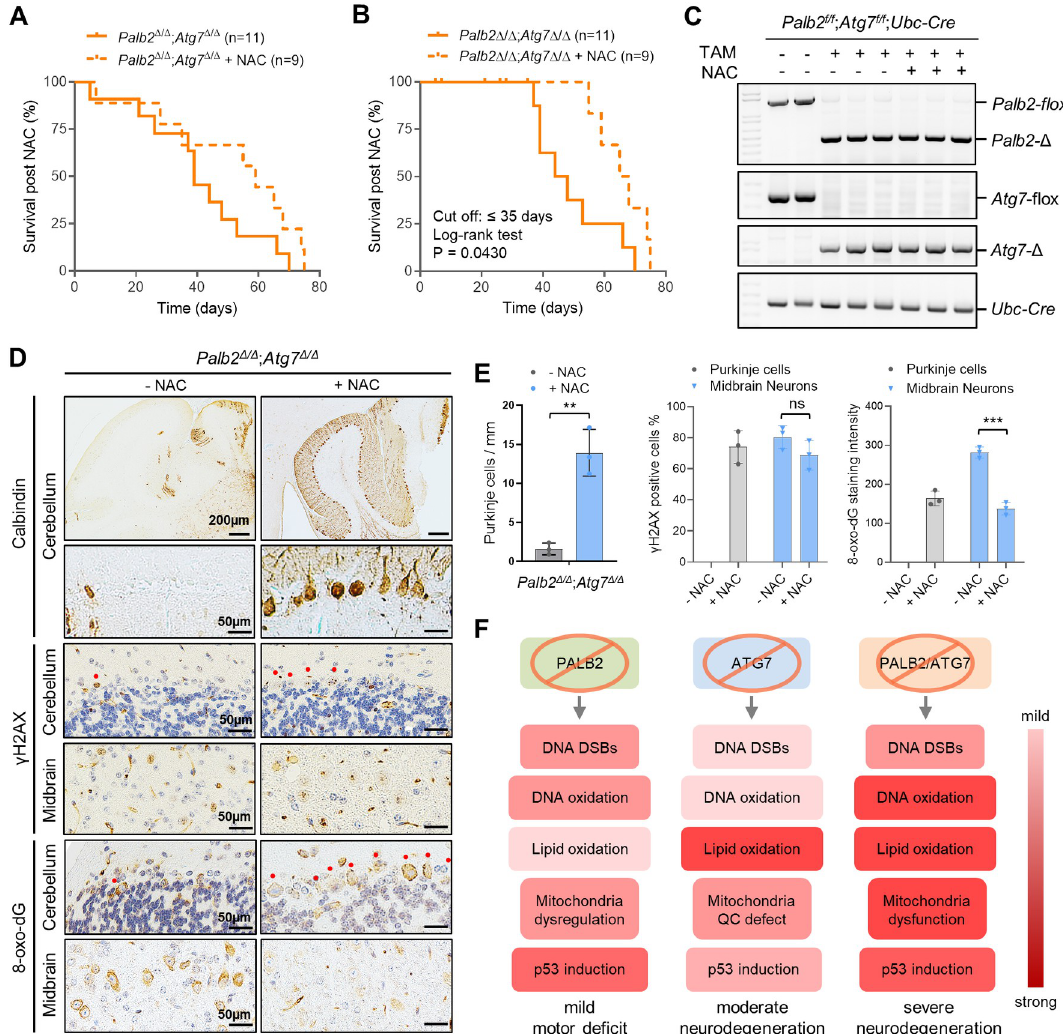
Fig 8. Partial rescue of Palb2;Atg7 -WBKO mouse survival by an ROS scavenger and a summary of key events occurring in the brain of the model mice in this study. (A and B) Survival curves of untreated (n = 11) and NAC-treated (n = 9) Palb2;Atg7 -WBKO mice. Panel A includes all cause deaths, while in panel B deaths that occurred within the first 35 days were treated as censoring events due to causes unrelated to neurodegeneration. (C) PCR detection of tamoxifen induced, Ubc-Cre-ERT2 -mediated Palb2 or Atg7 deletion in the liver of the mice (note that the whole brain was fixed for all mice). (D) Representative IHC images of Calbindin, γ H2AX and 8-oxo-dG in the cerebellum and midbrain of Palb2;Atg7 -WBKO mice with or without 8 days of NAC treatment. Red dots indicate Purkinje cells. Scale bar = 200 μ m or 50 μ m as indicated. n = 3 mice per condition. (E) Quantification of Purkinje cell number, γ H2AX positivity and 8-oxo-dG staining intensity in the cerebellum/Purkinje cells and midbrain neurons of Palb2;Atg7 - WBKO mice with or without NAC treatment. n = 3 mice per condition. (F) A summary of the impact of PALB2 and ATG7 loss on DNA damage (DSBs), DNA oxidation, lipid peroxidation, mitochondria and p53 status. Colors from light to dark denote mild to strong effects. See texts for